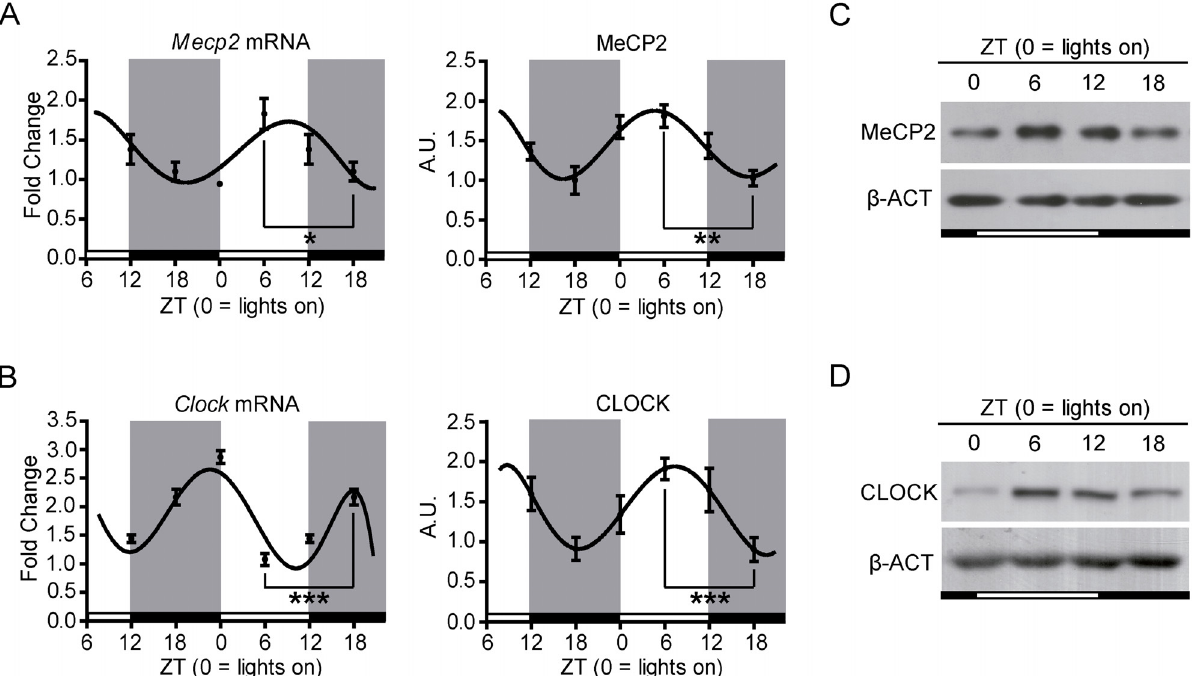
Fig 1. Circadian oscillations of MeCP2 and CLOCK proteins in mouse frontal cortex . RT-qPCR results and densitometric analysis of WB experiments, showing differences in (A) MeCP2 and (B) CLOCK expression. Mice were under constant 12 hour light-dark cycles (white and grey background represent lights on and off, respectively) and were processed at the indicated ZTs (Zeitgeber times in hours) (n = 10/ time point, means ± SEM are represented). Both MeCP2 and CLOCK levels are significantly different between ZTs 6 and 18. (C), (D) Representative MeCP2 and CLOCK WBs (white and black bars represent, respectively, lights on and off). * P < 0.05, ** P < 0.005, *** p < 0.0005 in two-tailed Student ’ s t